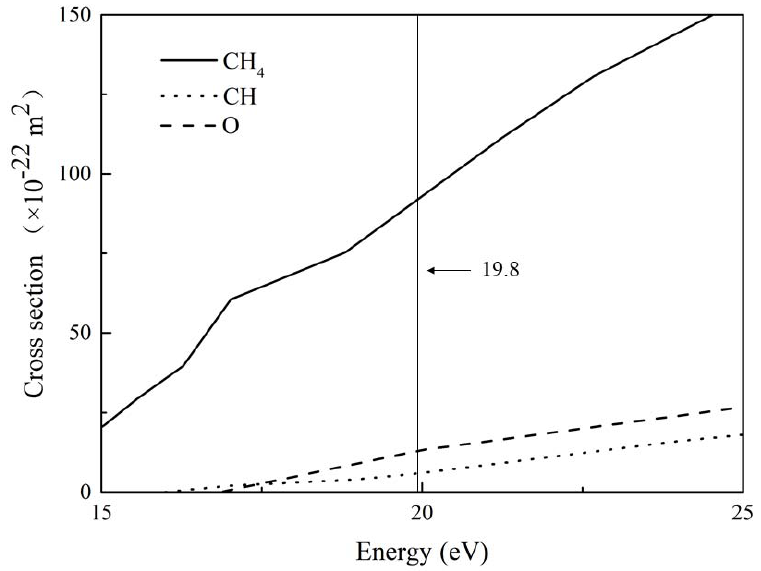
Figure 6. Partial cross section data of CH 4 (solid line), CH (dot line), and O (dash line) obtained from the Plasma Data Exchange Project [33,37,38].